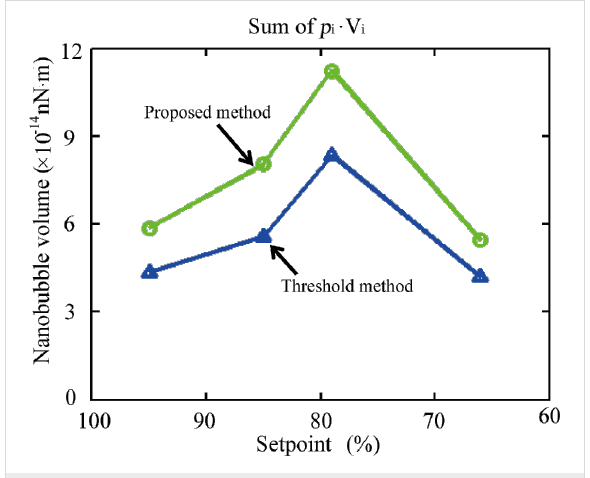
Figure 11: Sum of p i ∙ V i obtained with the threshold method and the proposed method for images shown in Figure